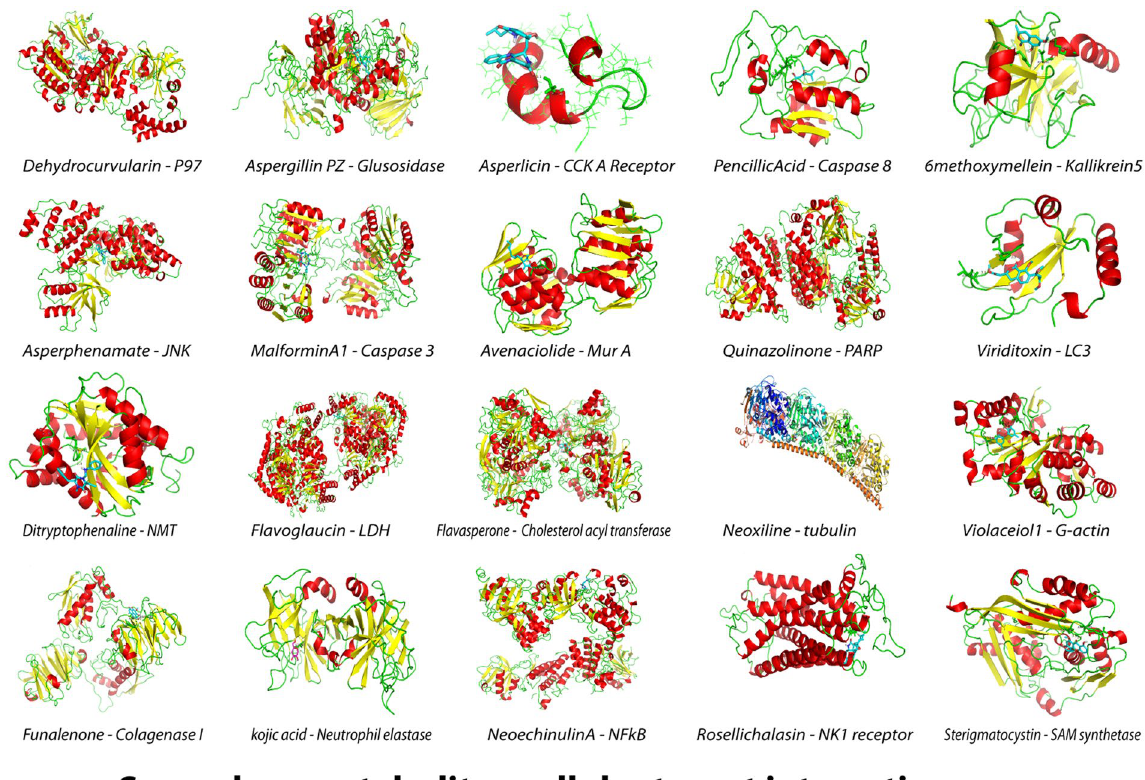
Figure 4. Molecular docking models representing secondary metabolite and cellular target interactions as reported in literature. Docking was performed using Auto Dock Vena. The protein structure was from PDB, metabolite structure from one of the chemical databases as explained in the text and binding energies are also